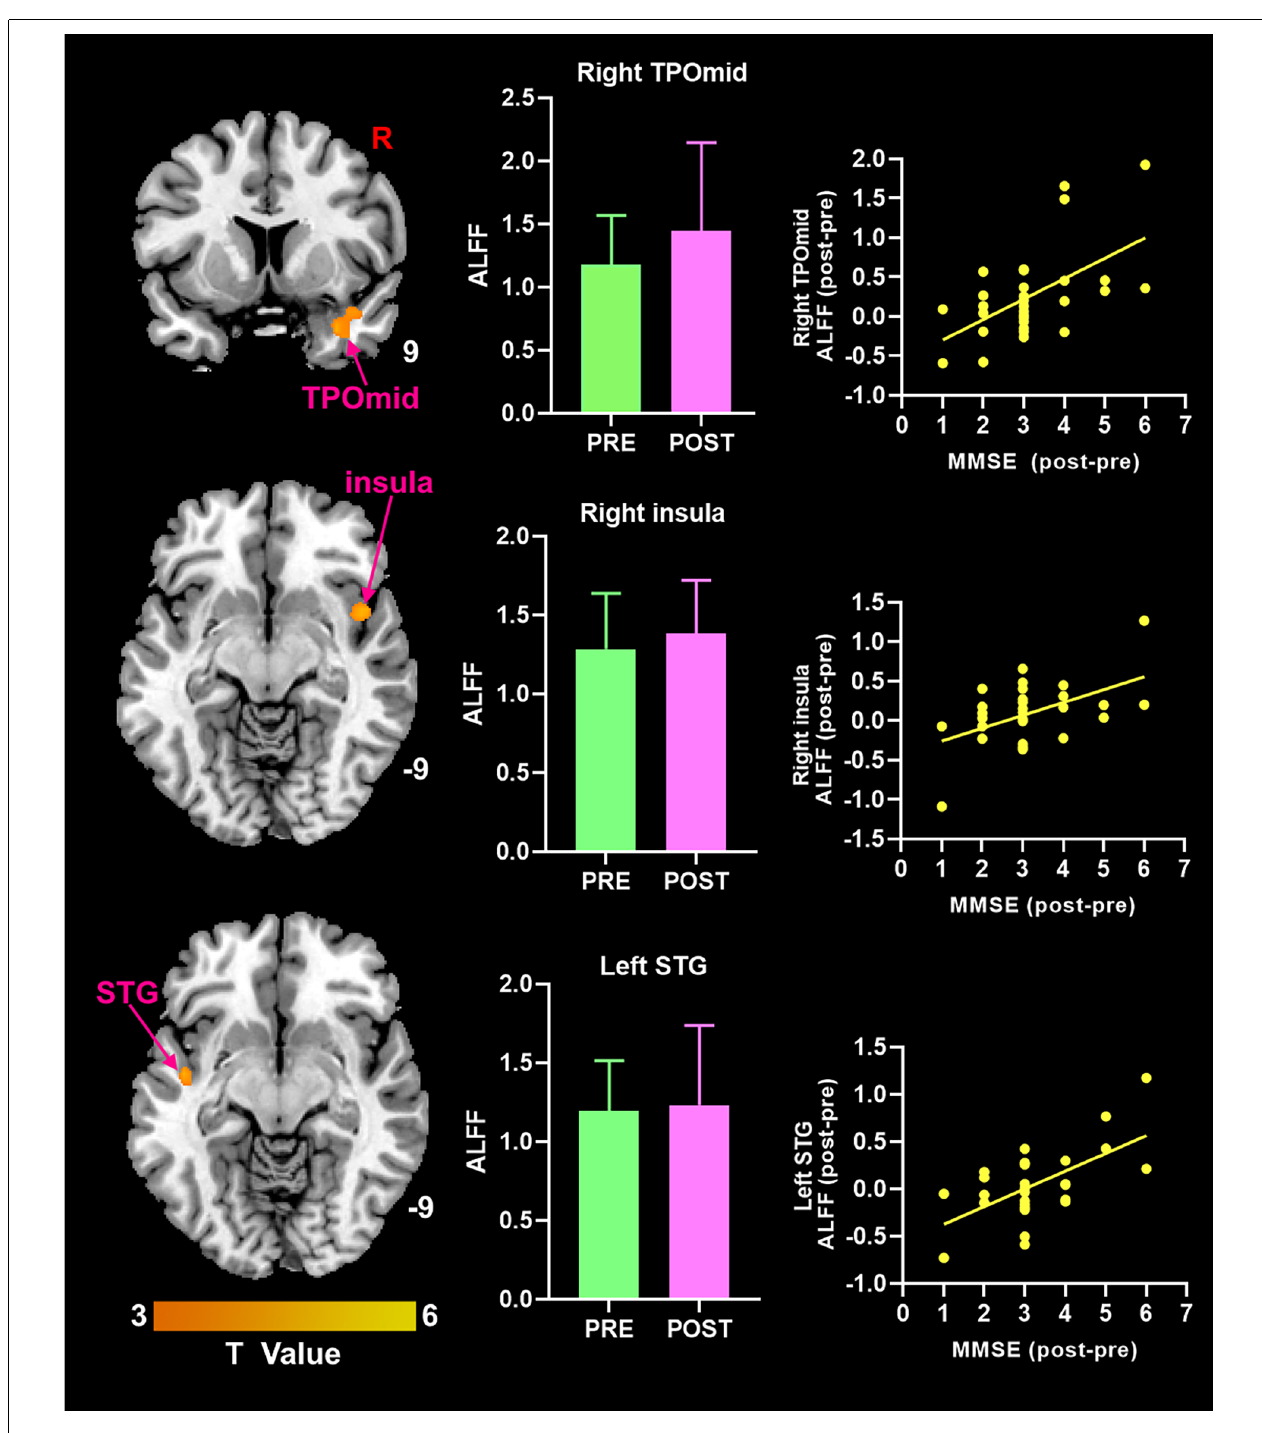
FIGURE 3 | The increase of MMSE score was positively correlated with the increase of ALFF value in brain regions ( p < 0.05, FDR correction). ALFF, amplitude of low-frequency fluctuation; MMSE, Mini-Mental State Examination; TPOmid, temporal poles: middle temporal gyrus; STG, superior temporal